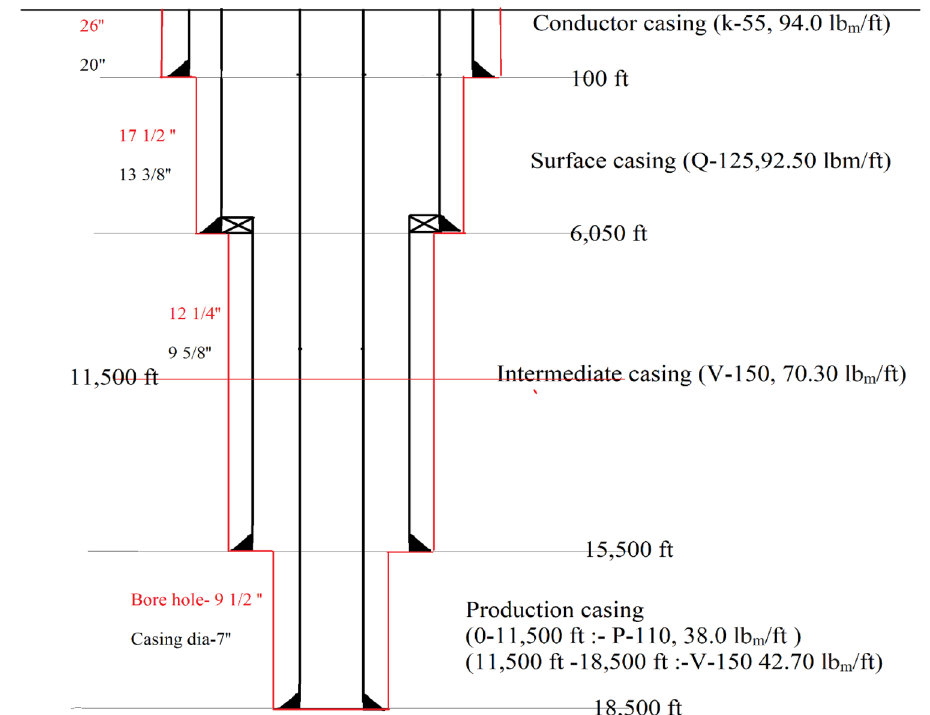
Fig. 21 Proposed well design by